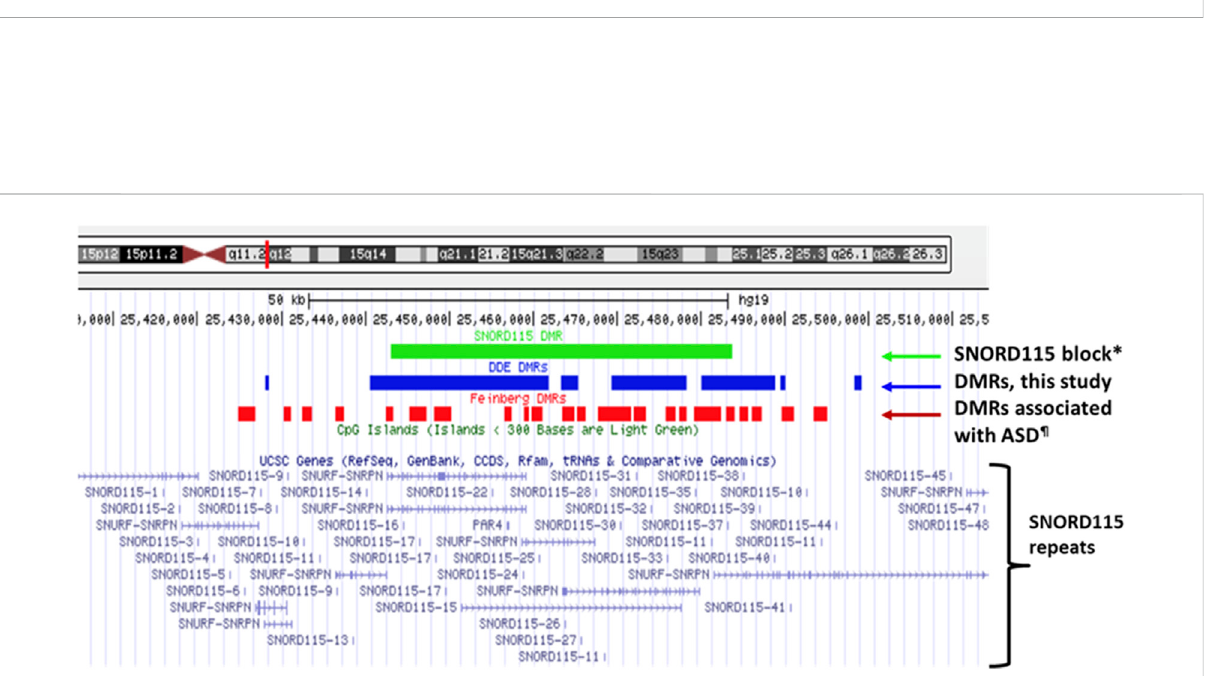
FIGURE 5 Heatmaps (A,B) andManhattanplots (C,D) depictingtheresultsoftheWGBSanalyses.DMRsfromtheDiscoveryset (A) andValidationset (B) are shownintheheatmaps. Allsigni fi cantDMRs arerepresentedabovethehorizontallinesintheManhattan plots(C=Discoveryset; D=Validationset).